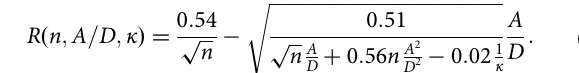
484 skyrmions in a fi lm of 400 nm × 346 nm × 1 nm. The model parameters are A = 5 pJ m − 1 , D = 3 mJ m − 2 , K u = 30 kJ m − 3 ( K = 4.88 kJ m − 3 ), M s = 0.2 MA m − 1 . Figure 3a – c show that the areas of m z > 0 and m z < 0 are different, and have different spin distribution. Lattice constant and skyrmion size are two obvious